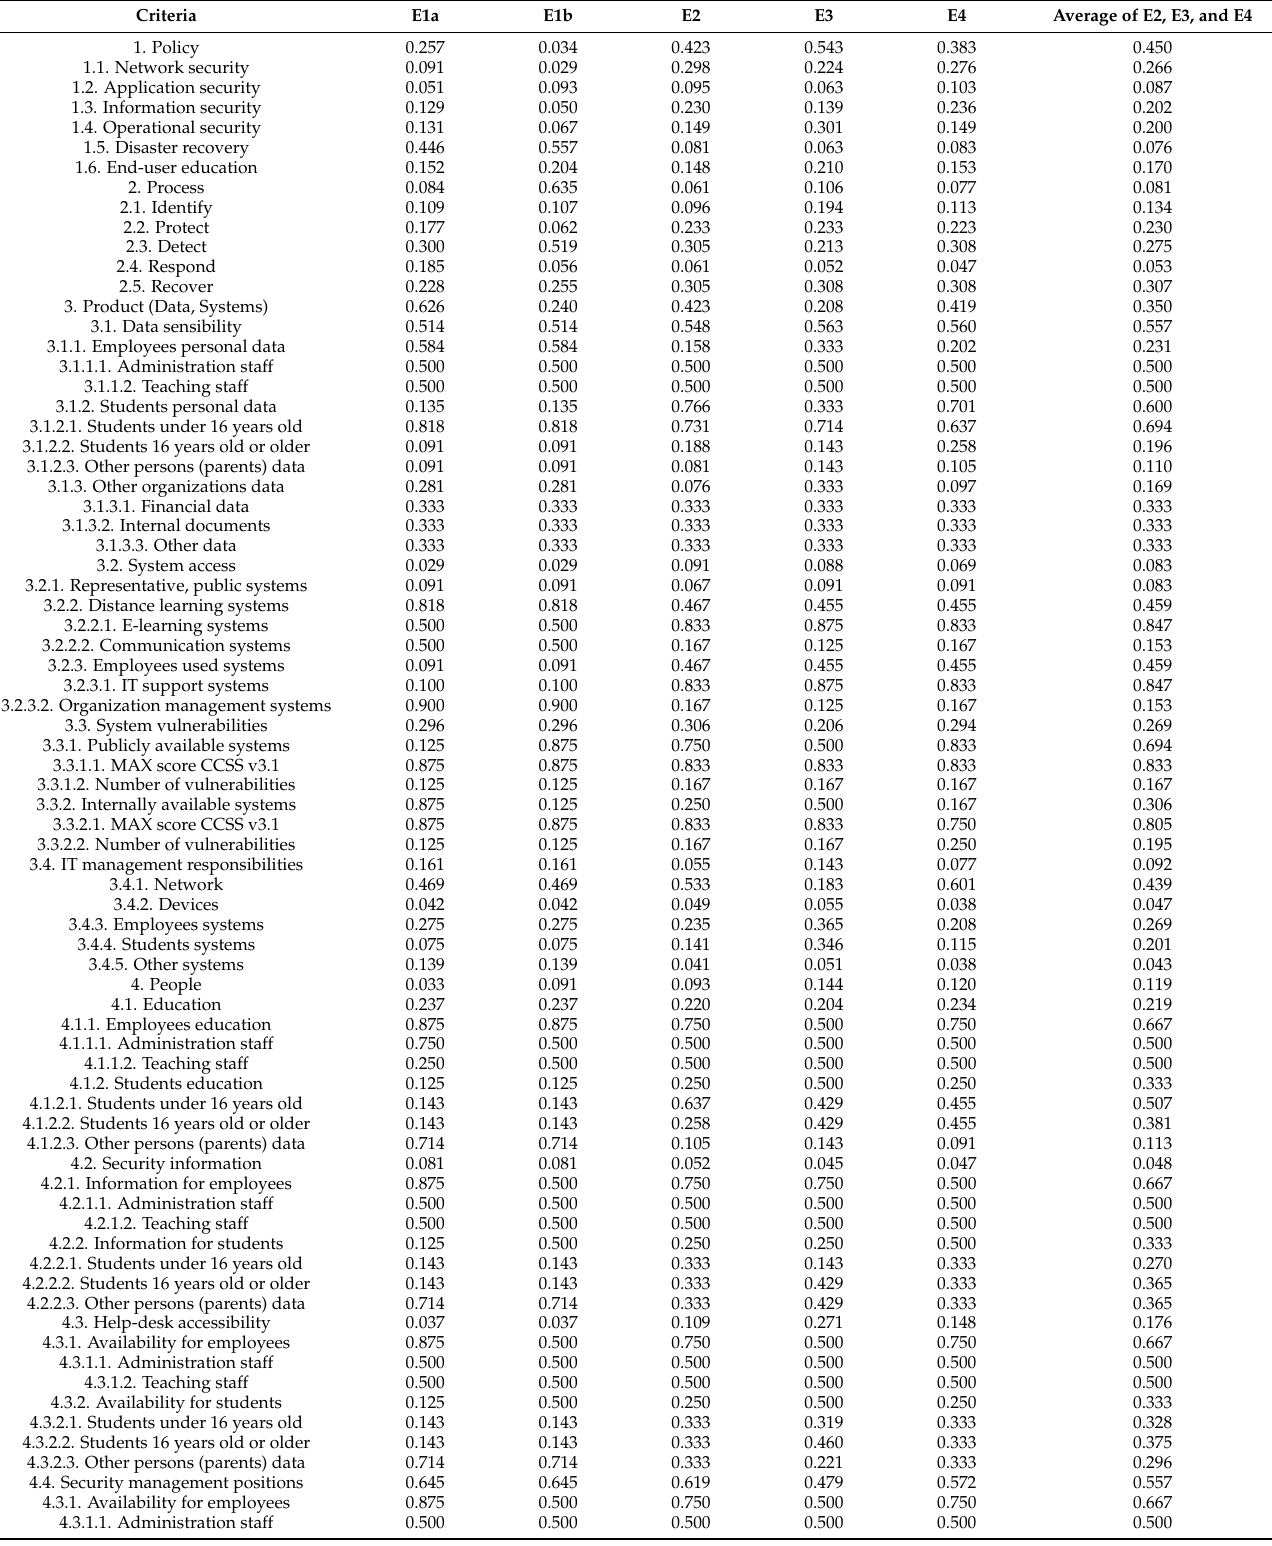
Table A1. The AHP criteria tree and calculated experts criteria importance coefficients.